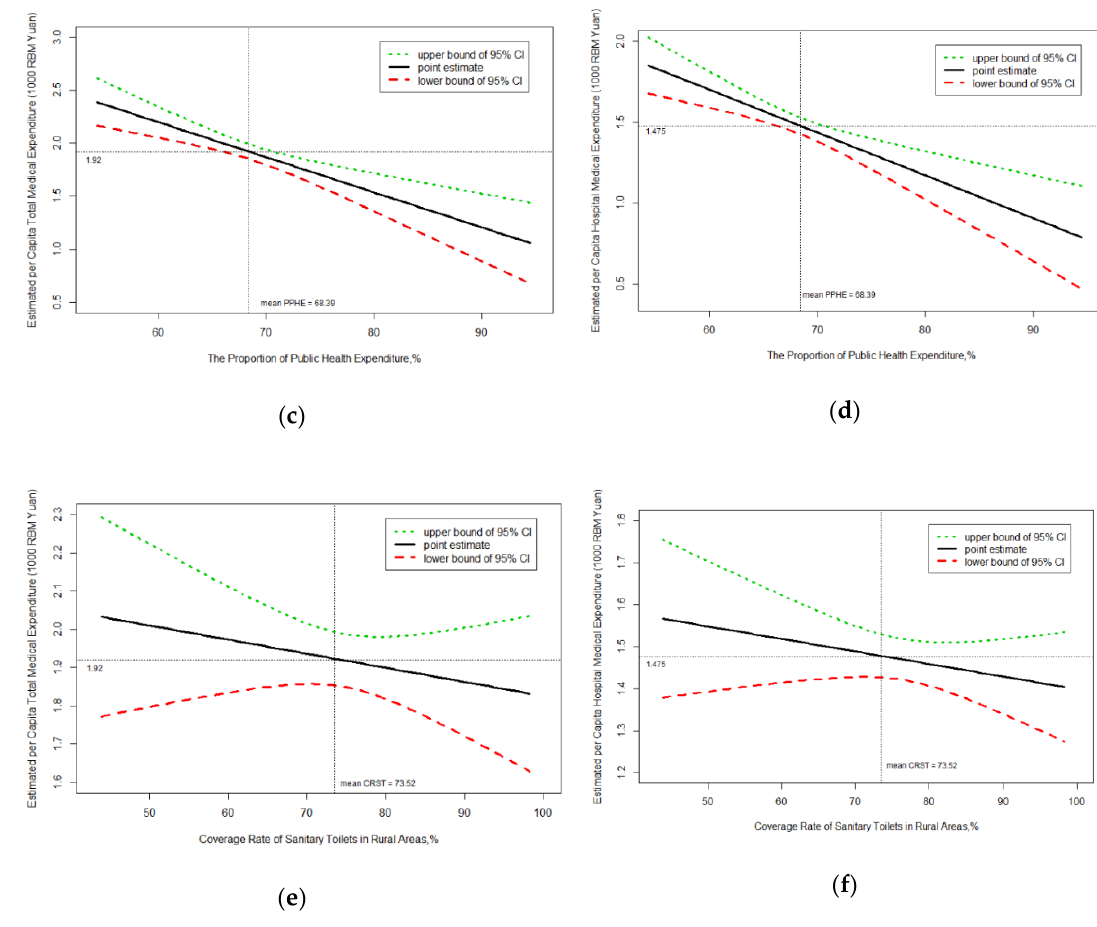
Figure 1. Estimated medical expenditures and 95% confidence intervals (CIs) versus three predictor variables. The estimation is based on a linear mixed-effects model. ( a ) Estimated total expenditure versus primary care physicians supply in year 2015; ( b ) estimated hospital medical expenditure versus primary care physicians supply in year 2015; ( c ) estimated total expenditure versus proportion of public health expenditure in year 2015; ( d ) estimated hospital medical expenditure versus proportion of public health expenditure in year 2015; ( e ) estimated total expenditure versus popularity rate of sanitary toilets in rural areas in year 2015; ( f ) estimated hospital medical expenditure versus popularity rate of sanitary toilets in rural areas in year 2015.